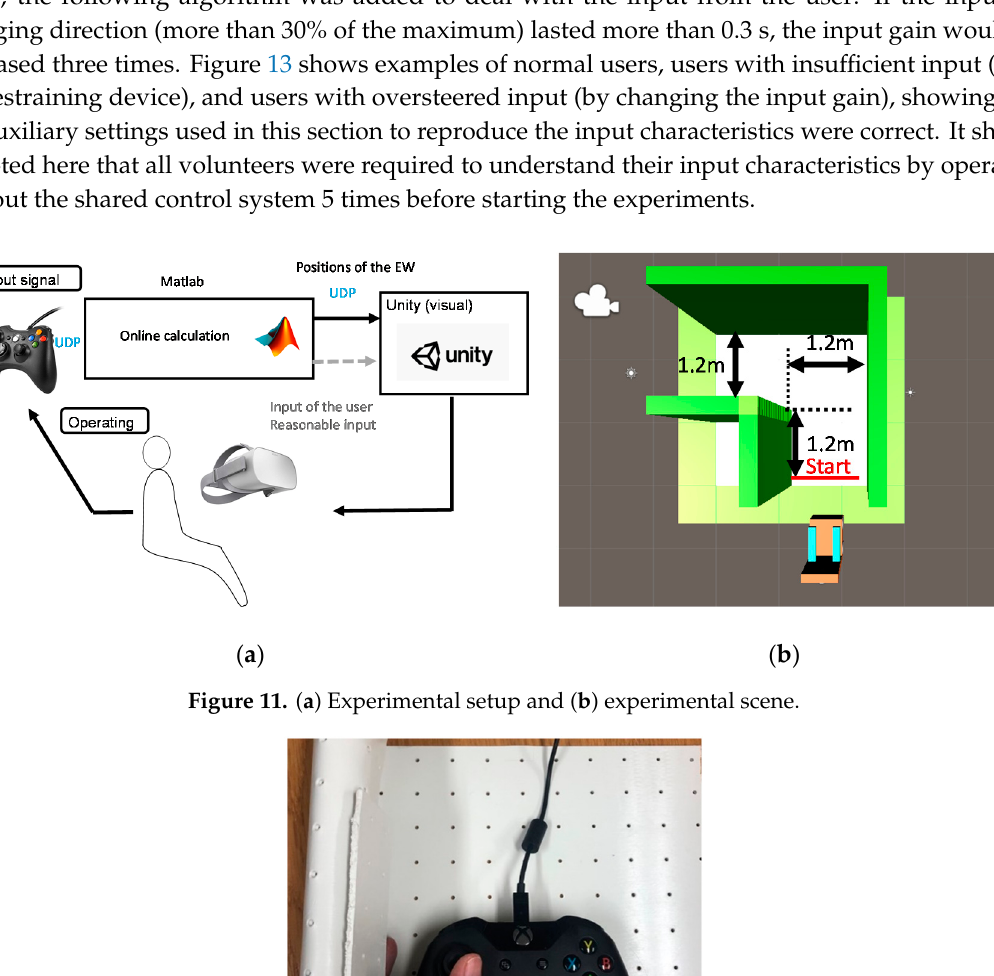
12 of 19 Table 3. Shared control algorithm for EW driving. Algorithm: Sarsa Learning-Based Shared Control Algorithm 1. (cid:1872) = 0, (cid:2011) = 0.8, (cid:2009) (cid:3047) = 0.05, (cid:1844) (cid:3047) calculated by reward function 2. Recursively compute until the stop condition is met 3. Recursively compute until reaching the goal 4. Obtain current state (cid:1845) (cid:3047) 5. Decide action (cid:1827) (cid:3047) = ((cid:1863) (cid:3049) , (cid:1863) (cid:3103)(cid:4662) ) by Sarsa learning 6. Send (cid:3435)(cid:1863) (cid:3049) , (cid:1863) (cid:3103)(cid:4662) (cid:3439) to the system, calculate output ((cid:1874), (cid:2032)(cid:4662)) 7. Send output ((cid:1874), (cid:2032)(cid:4662)) to the EW 8. Calculate the next state (cid:1845) (cid:3047)(cid:2878)(cid:2869) 9. Update the Q-table, Load (cid:1844) (cid:3047) The stop condition of the training process was set as follows: 1. Q ( s , a ) for each state only changes to a certain value. 2.